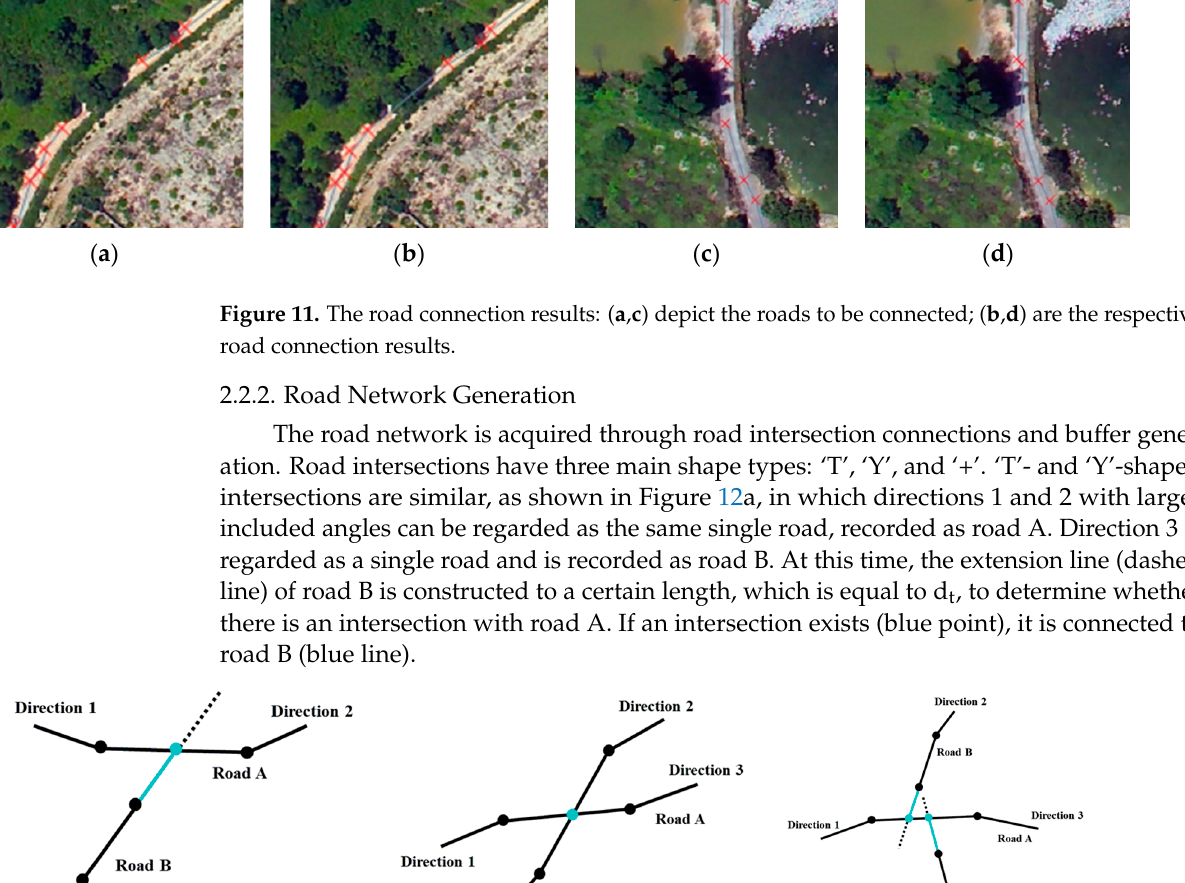
Figure 13. Intersection connection results: ( a , c , e ) depict the road intersections before the connection is performed and ( b , d , f ) are the results of the intersection connection algorithm. The intersection connection algorithm is shown in Algorithm 3: Algorithm 3: Intersection Connection Input: Lines Roads Output: addLines Newly added connection roads 1: